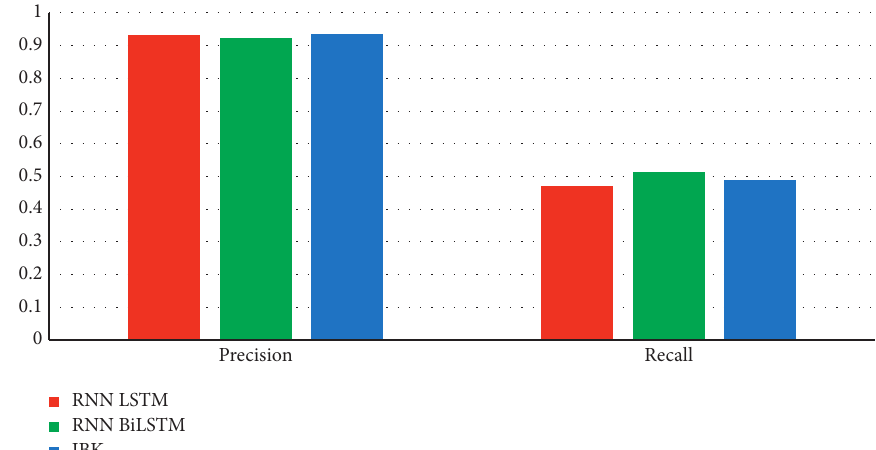
Figure 6: Performance comparison of RNN and IBK algorithms based NN-QuPiD Attack with query string feature